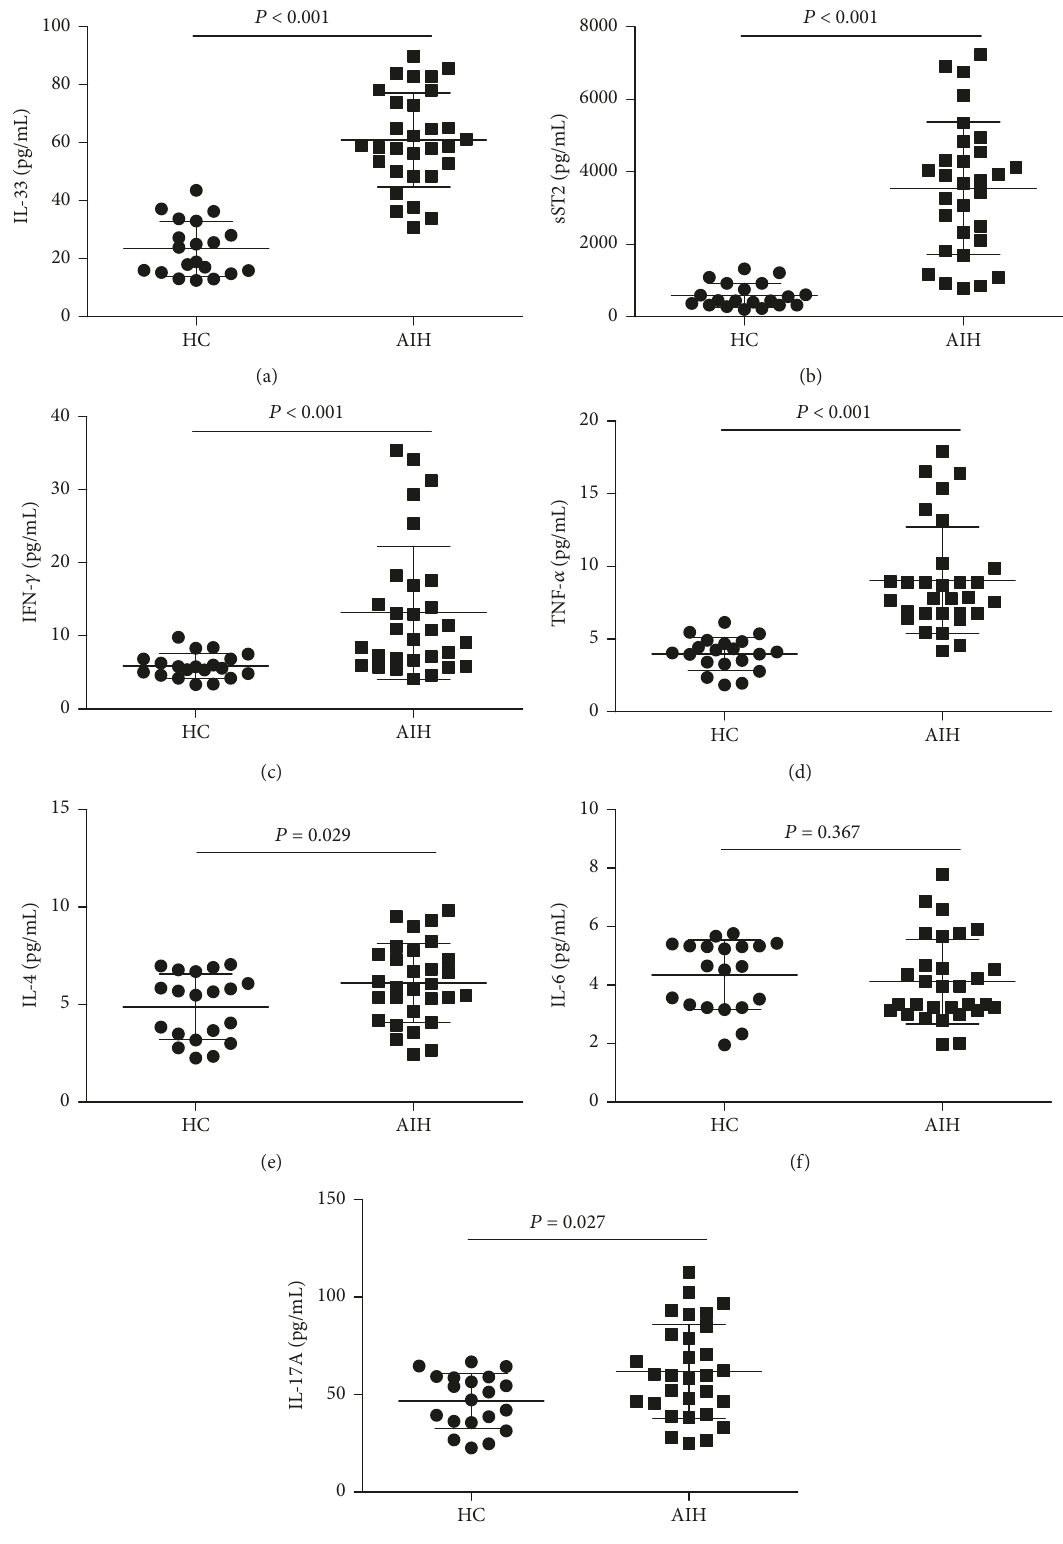
Figure 1: Serum levels of IL-33, sST2, and other cytokines in AIH patients and HCs. Serum levels of (a) IL-33, (b) sST2, (c) IFN- γ , (d) TNF- α , (e) IL-4, (f) IL-6, and (g) IL-17A in AIH patients during active state and in HCs. Data shown are the mean levels of each serum cytokine in individual subject from two separate experiments. The horizontal lines indicate the mean values for the di ff erent